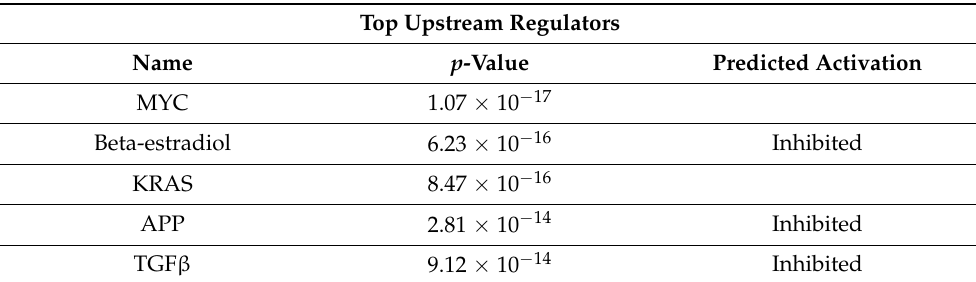
Table 2. Top upstream regulators from the IPA core analysis of differentially expressed genes between 8-wk-old Winnie- APC Min/+ -TNF-KO mice and Winnie- APC Min/+